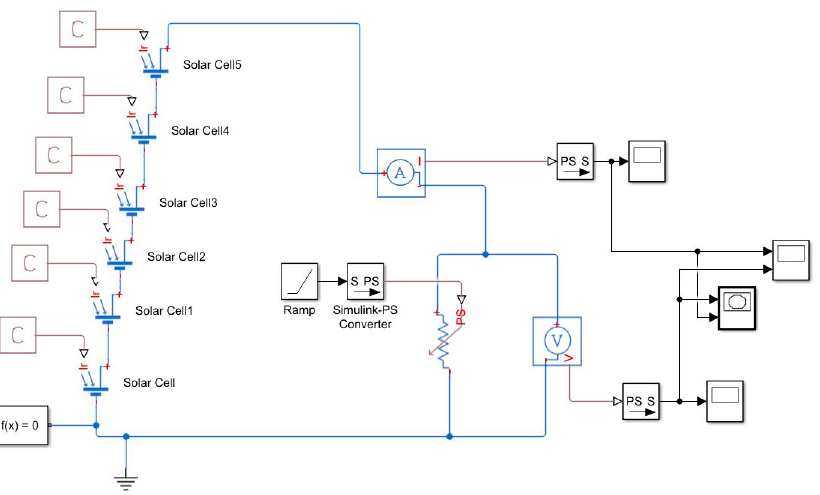
Figure 10. Matlab simulation of a panel composed of 36 cells (6 groups of 6 identical cells) in series. Each of these groups of cells has a value for the parallel resistance that can be 0.2 Ω , 0.4 Ω or 0.6 Ω .